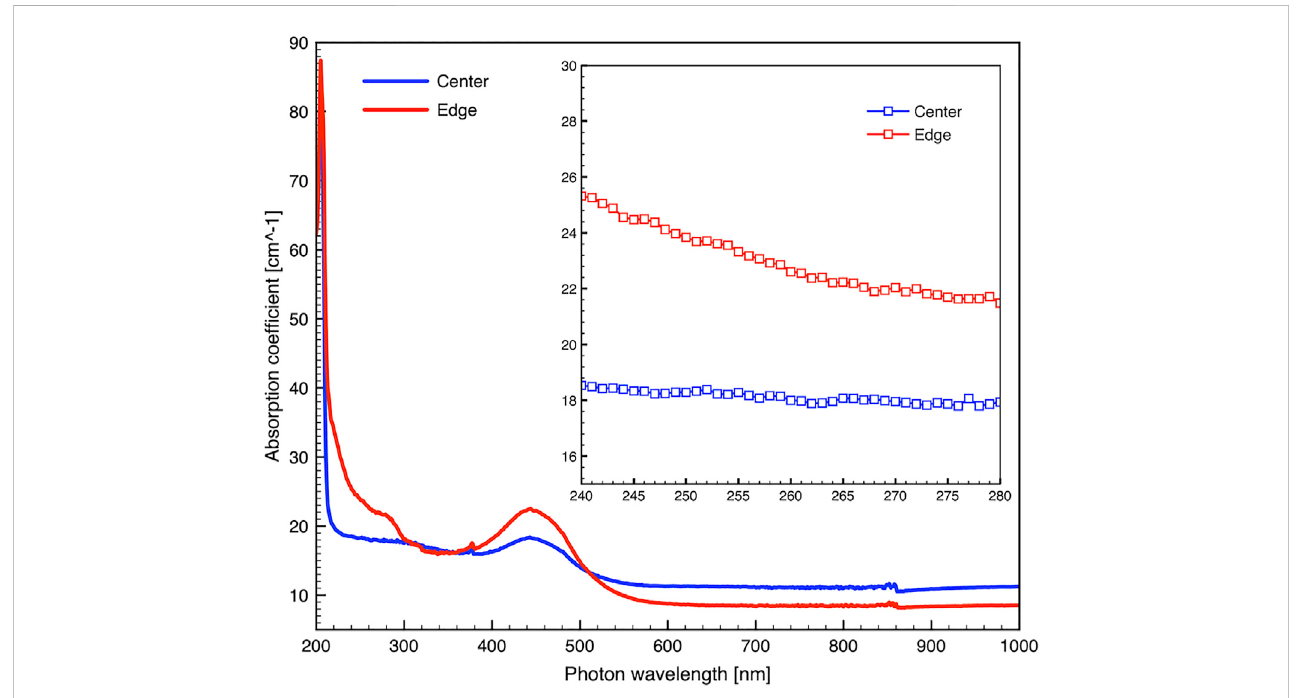
FIGURE 7 Absorption spectra of the center and edge positions of the Φ 75 mm sample